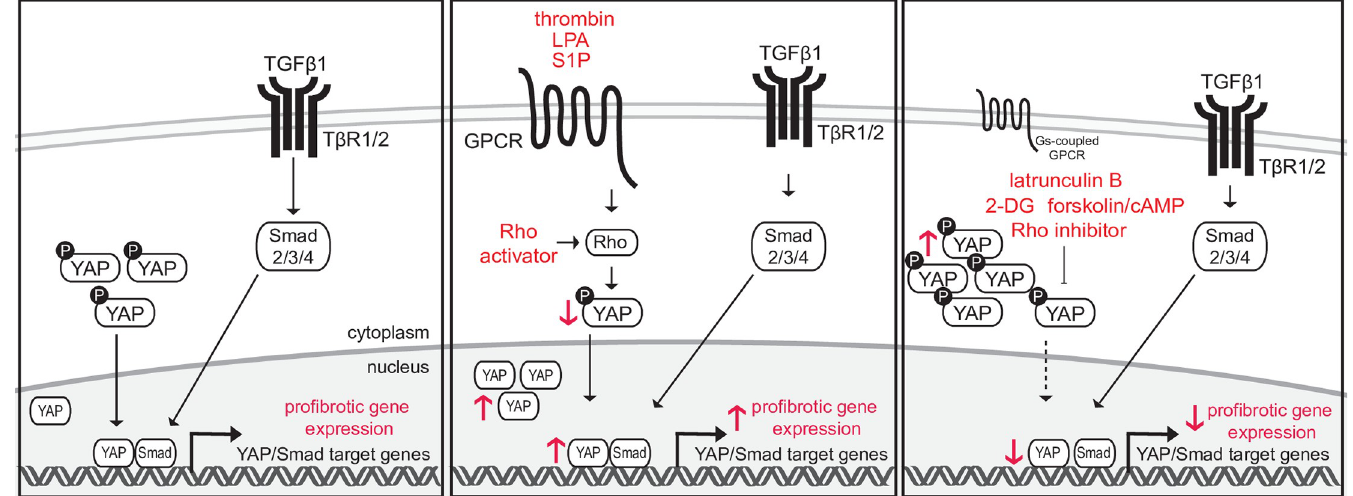
Fig 5. Schematic representation of the proposed mechanism. TGF β 1 leads to activation of Smad2/3/4 complexes and their nuclear translocation. In the nucleus, they are using YAP as a co-activator to induce transcription of YAP/Smad target genes, many of which are implicated in fibrogenesis. If GPCR ligands LPA, S1P or thrombin are present at the same time, they activate their receptors and trigger Rho activation. YAP is then dephosphorylated and accumulates in the nucleus. This increases the response to TGF β 1 by enhancing the expression of YAP/Smad-target genes. Conversely, latrunculin B, forskolin, Rho inhibitor, 2-DG or GPCR ligands increasing cAMP levels decrease nuclear levels of YAP and hereby decrease the expression of profibrotic YAP/Smad target genes in response to TGF β 1.